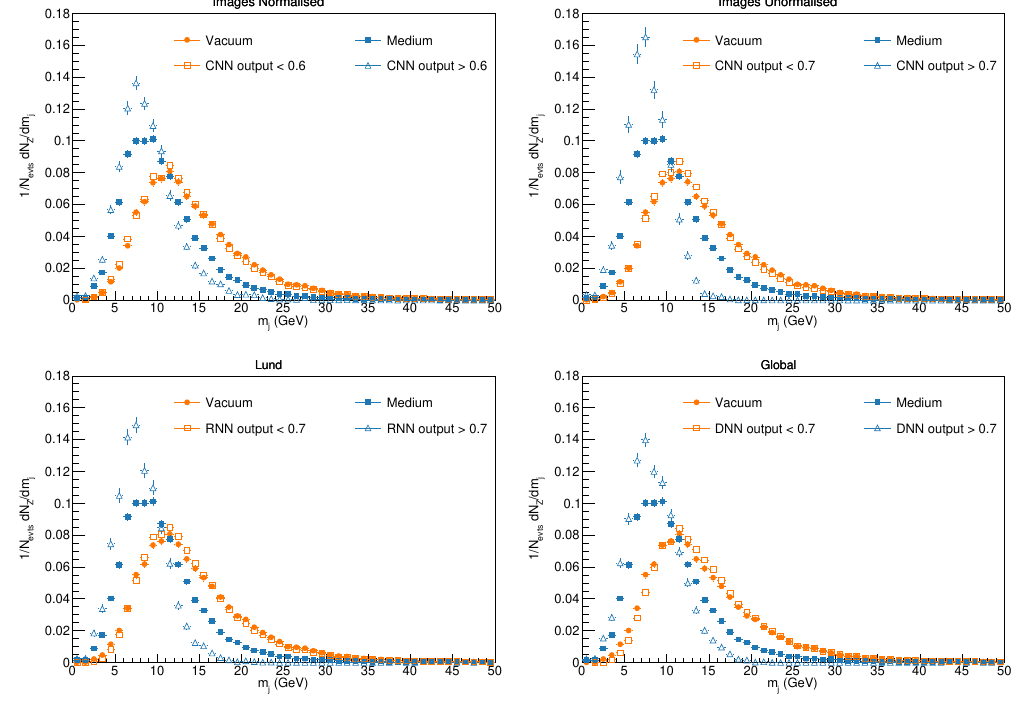
Figure 15 . Reconstructed jet mass m j , for the different Deep Learning architectures. Monte Carlo truth from JEWEL+PYTHIA is provided in solid symbols for the Vacuum and Medium samples and a subset of events selected by the DL discriminant appears in open symbols. The DL output selection employed to identify vacuum-like jets (open blue) and medium-like jets (open orange) is made explicit in the legend of each